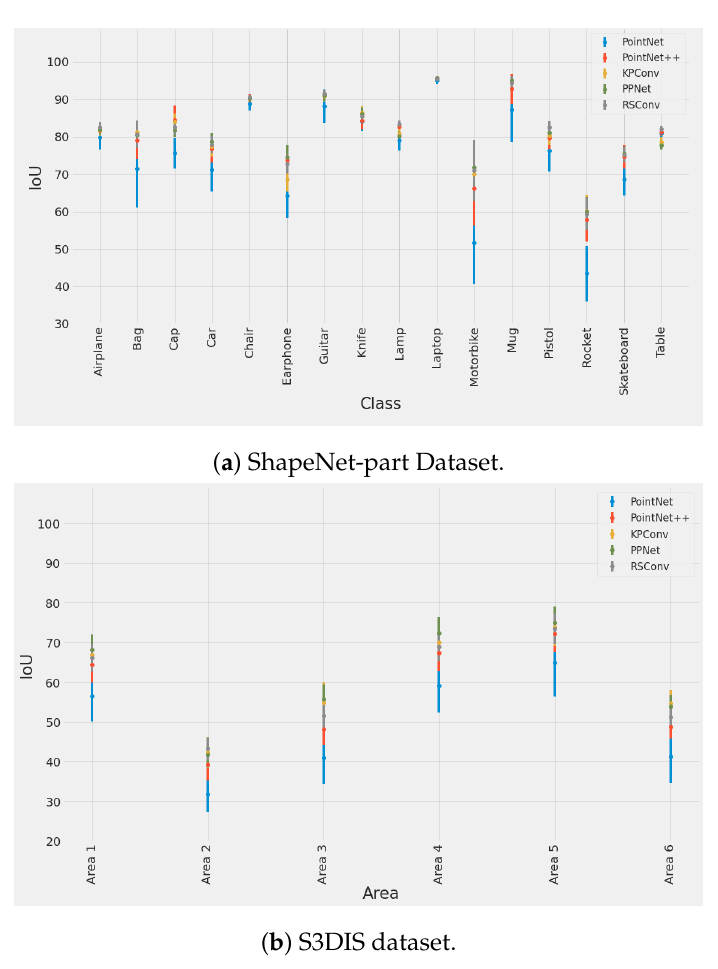
Figure 4. Comparison of deep learning models in terms of mIoU over all testing epochs. The bullet in the middle of each bar denotes the mean ( µ ) and the bar shows the error interval ( ± (cid:101) of the